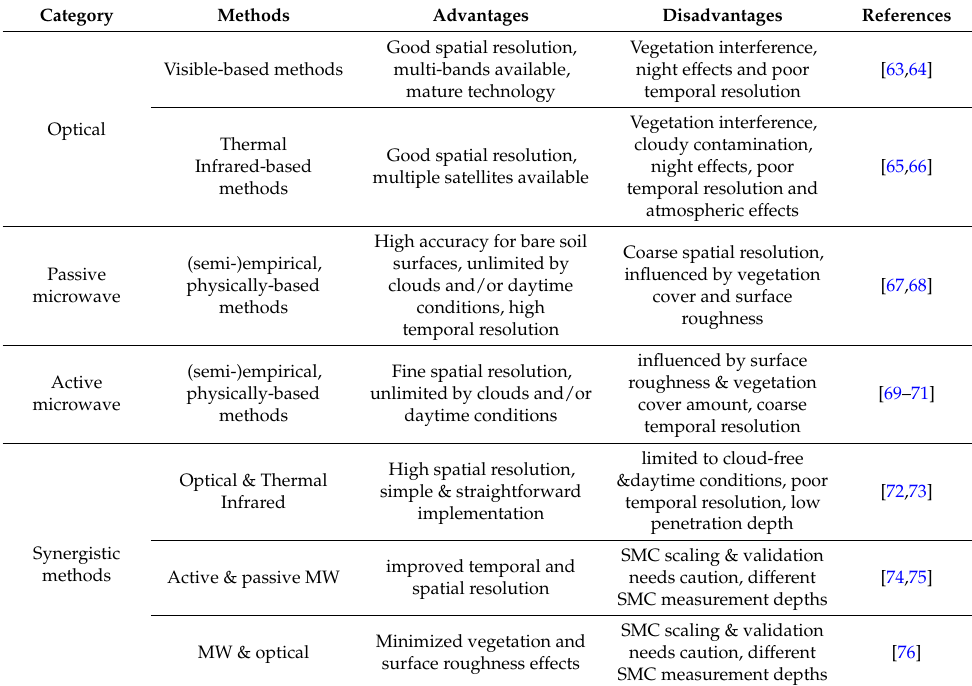
Table 1. Remotely sensed methods used in the soil moisture estimation study